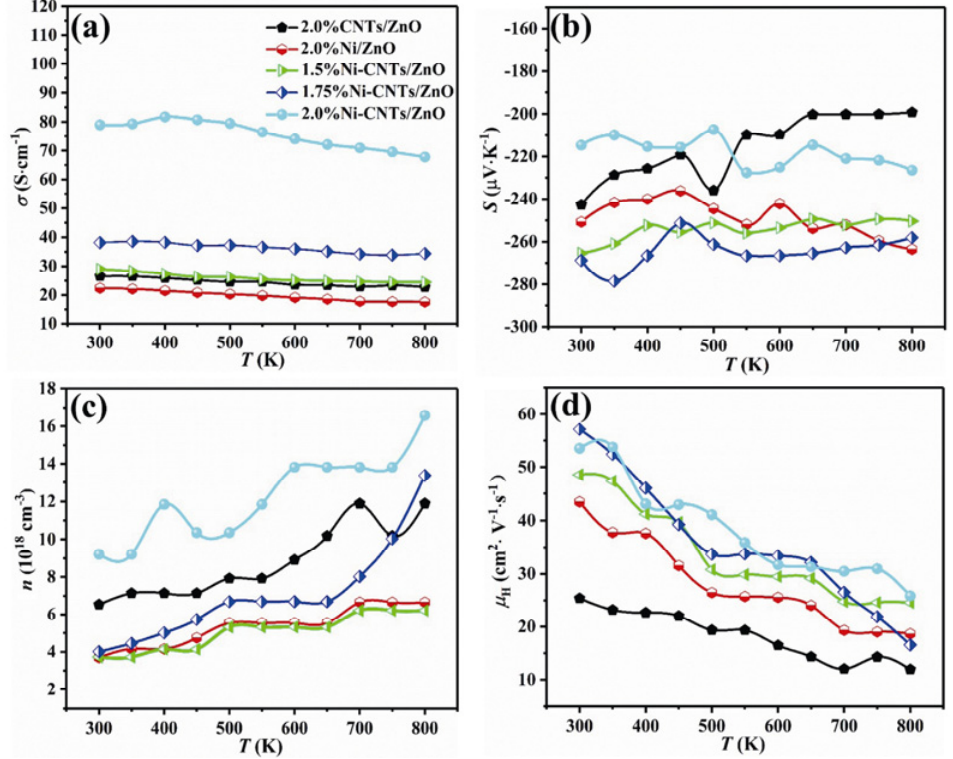
Fig. 5 Temperature dependence of (a) σ , (b) S , (c) n , and (d) μ H for ZnO-based